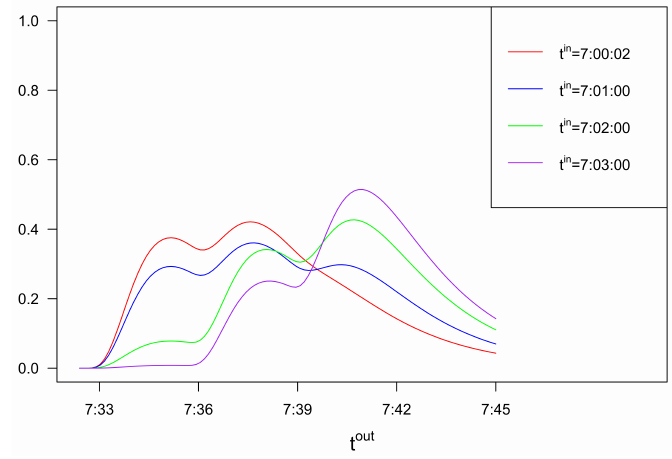
Figure 8. Conditional density functions of t out conditionally on different t in ’s.